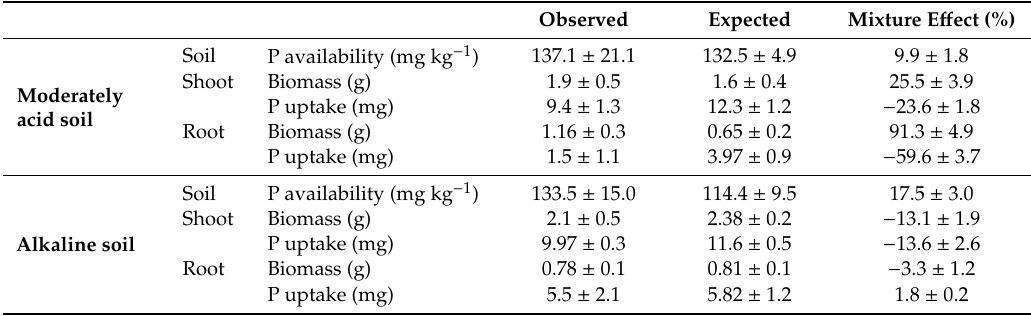
Table 6. Synergistic and antagonistic e ff ect on soil and plant parameters as the response of the combined application of poultry manure compost and phosphate rock applied at a P rate of 100 mg kg − 1 soil after 7 weeks of ryegrass growth. +